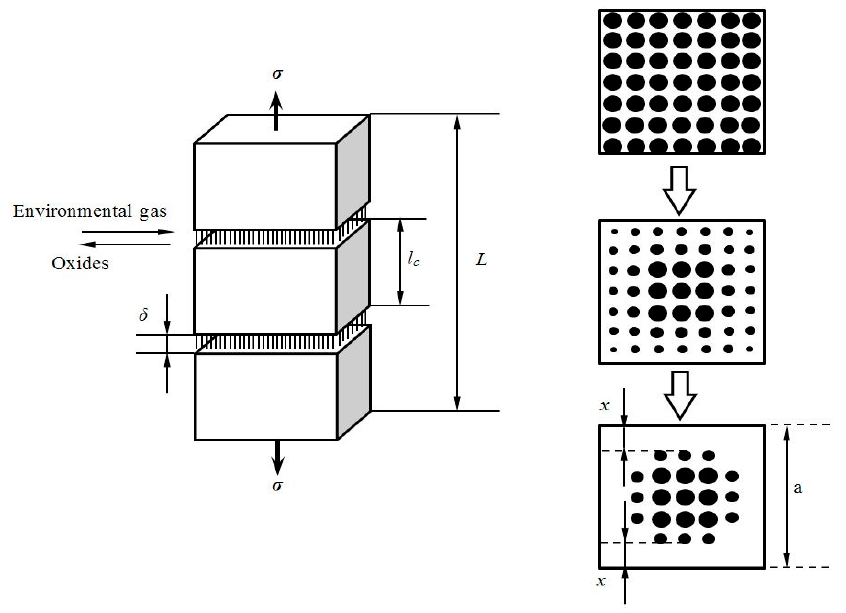
Figure 2. The schematic of fiber oxidation in multiple cracked fiber-reinforced ceramic-matrix composites. Under cyclic loading, the interface shear stress decreases due to interface wear. The interface debonded region can be divided into two regions, including: 1. The interface oxidation region, i.e., x [0, ξ ], where the stress transfer between the fiber and the matrix is controlled by a sliding stress τ i ( x ) = τ f .